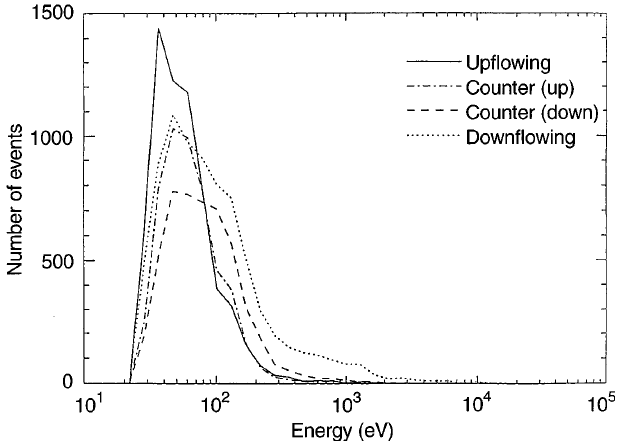
Fig. 3. Energy distribution of field-aligned electron beams associated with upflowing ion events. The four curves represent the four types of electron beam as shown in the